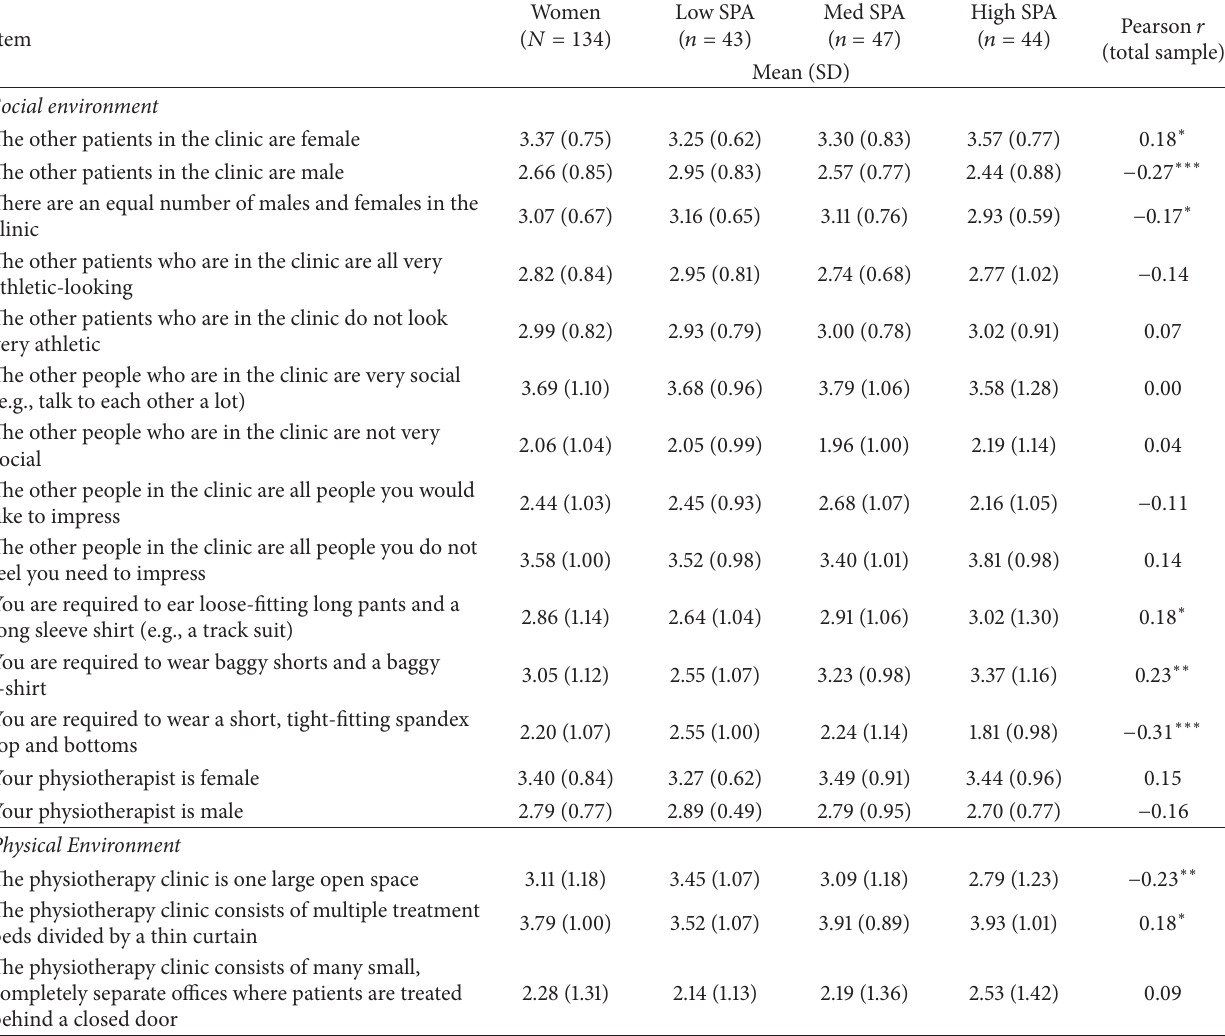
Table 3: Environmental preferences for female